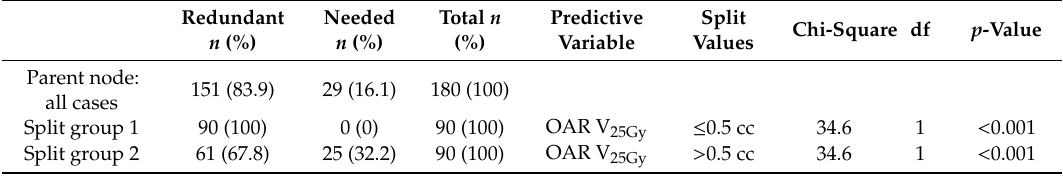
Table 3. Results in the Chi-square automatic interaction detection (CHAID) tree